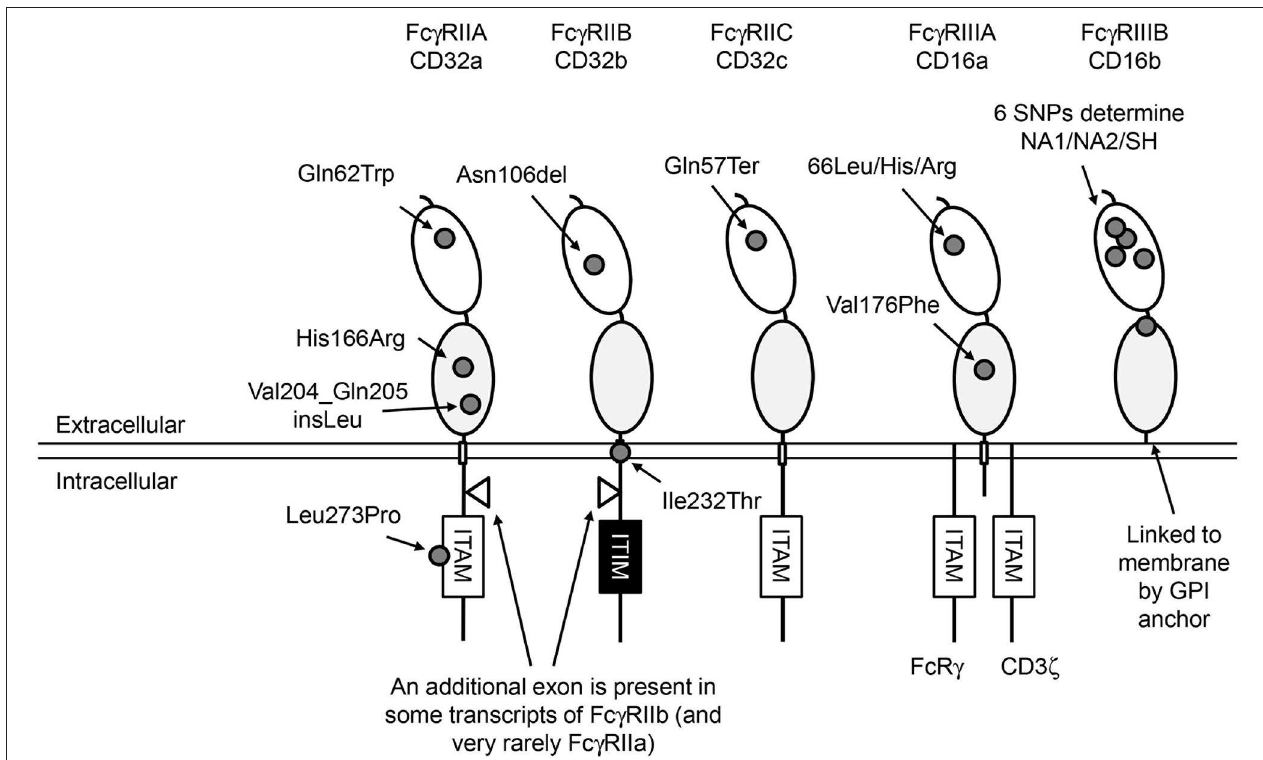
FIGURE 1 | Human Fc γ Rs. Overview of the structure of human low-to-medium-affinity Fc γ Rs. The oval shapes in the extracellular part of the Fc γ Rs represent the different extracellular domains; the light gray domains are the domains where IgG molecules bind. All Fc γ Rs except Fc γ RIIIB are linked to the plasma membrane by transmembrane (TM) domains indicated by small rectangles. Fc γ RIIIB is linked to the plasma membrane through a GPI anchor. Fc γ RIIIA has a small intracellular domain that associates with adaptor molecules that can initiate an intracellular signaling cascade when multiple Fc γ Rs are cross-linked, which ultimately leads to activation of the cell on which the Fc γ Rs are expressed. Fc γ RII receptors have a much larger intracellular domain, and contain a signaling motif to start this cascade in their own polypeptide chain. Signaling by activating Fc γ Rs is mediated by immunoreceptor tyrosine-based activating motifs (ITAM) that are present either in the cytoplasmic tail of the receptor itself or in non-covalently associated signaling adaptor proteins, such as the common γ -chain (FcR γ ). Aggregation of activating Fc γ R by binding of multivalent ligands, such as an opsonized pathogen or blood cell or an immune complex, results in the phosphorylation of ITAM tyrosine residues by Src family protein tyrosine kinases (PTKs), and ultimately leads to activation of cellular responses (1). Aggregation of the inhibitory Fc γ RIIB, which contains an immunoreceptor tyrosine-based inhibitory motif (ITIM), also results in phosphorylation of tyrosine residues by Src family PTKs. In contrast to ITAMs, phosphorylated ITIMs serve as binding sites for phosphotyrosine phosphatases (PTPs) which dephosphorylate other proteins resulting in inhibition of activating pathways (2). Approximate location of functional SNPs in the Fc γ Rs are indicated by small gray circles, SNPs are indicated by 3-letter amino-acid codes. ITAM, immunoreceptor tyrosine-based activating motif; ITIM, immunoreceptor tyrosine-based inhibitory